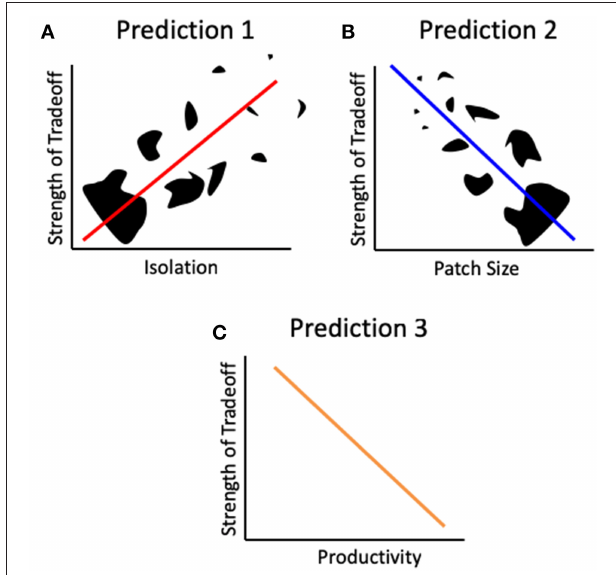
FIGURE 2 | Predictions derived from the landscape physiology framework. Patch isolation Black shapes represent patches of different shapes and sizes. The strength of the tradeoff between reproduction and dispersal will increase with patch isolation (A) , decrease with patch size (B) and patch productivity (C)